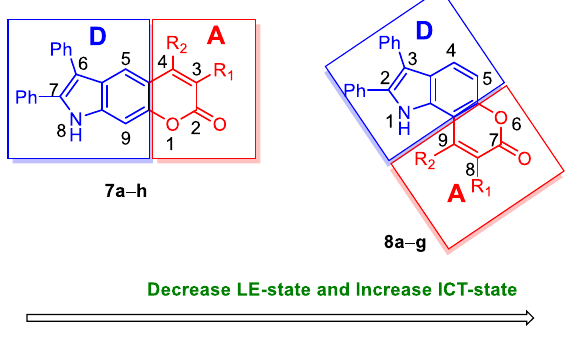
Figure 8. Donor-Acceptor model of two isomeric pyranoindoles with linear [3,2- f ] and angular [2,3- g ] type of ring fusion, and general influence 3,4-/8,9-pyranoindol substitution and electron transfer angle on the degree of ICT-state of compounds 7 – 8 .